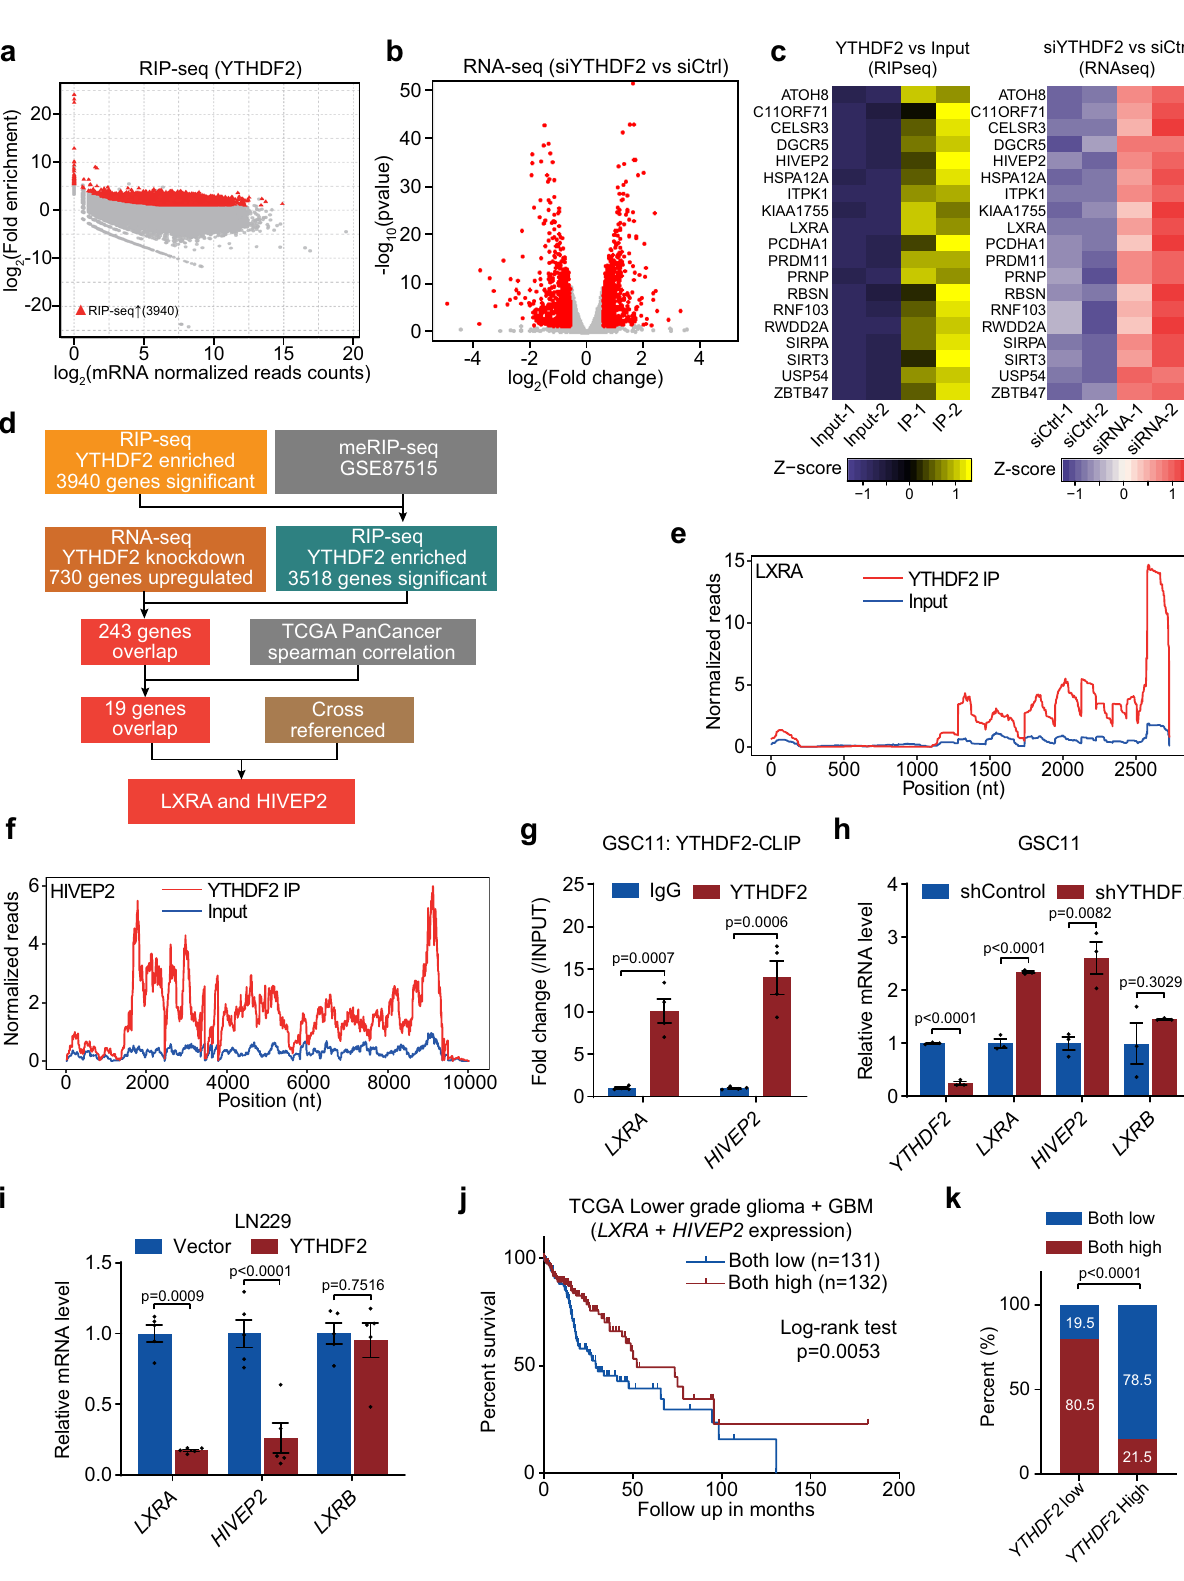
coupling represents a critical mechanism controlling the down- regulation of LXRA and HIVEP2 gene expression in GBM tumorigenesis (Supplementary Fig. 8). GBM cells are highly dependent on cholesterol for survival 29 , and therefore activation of LXR subjected GBM cells to